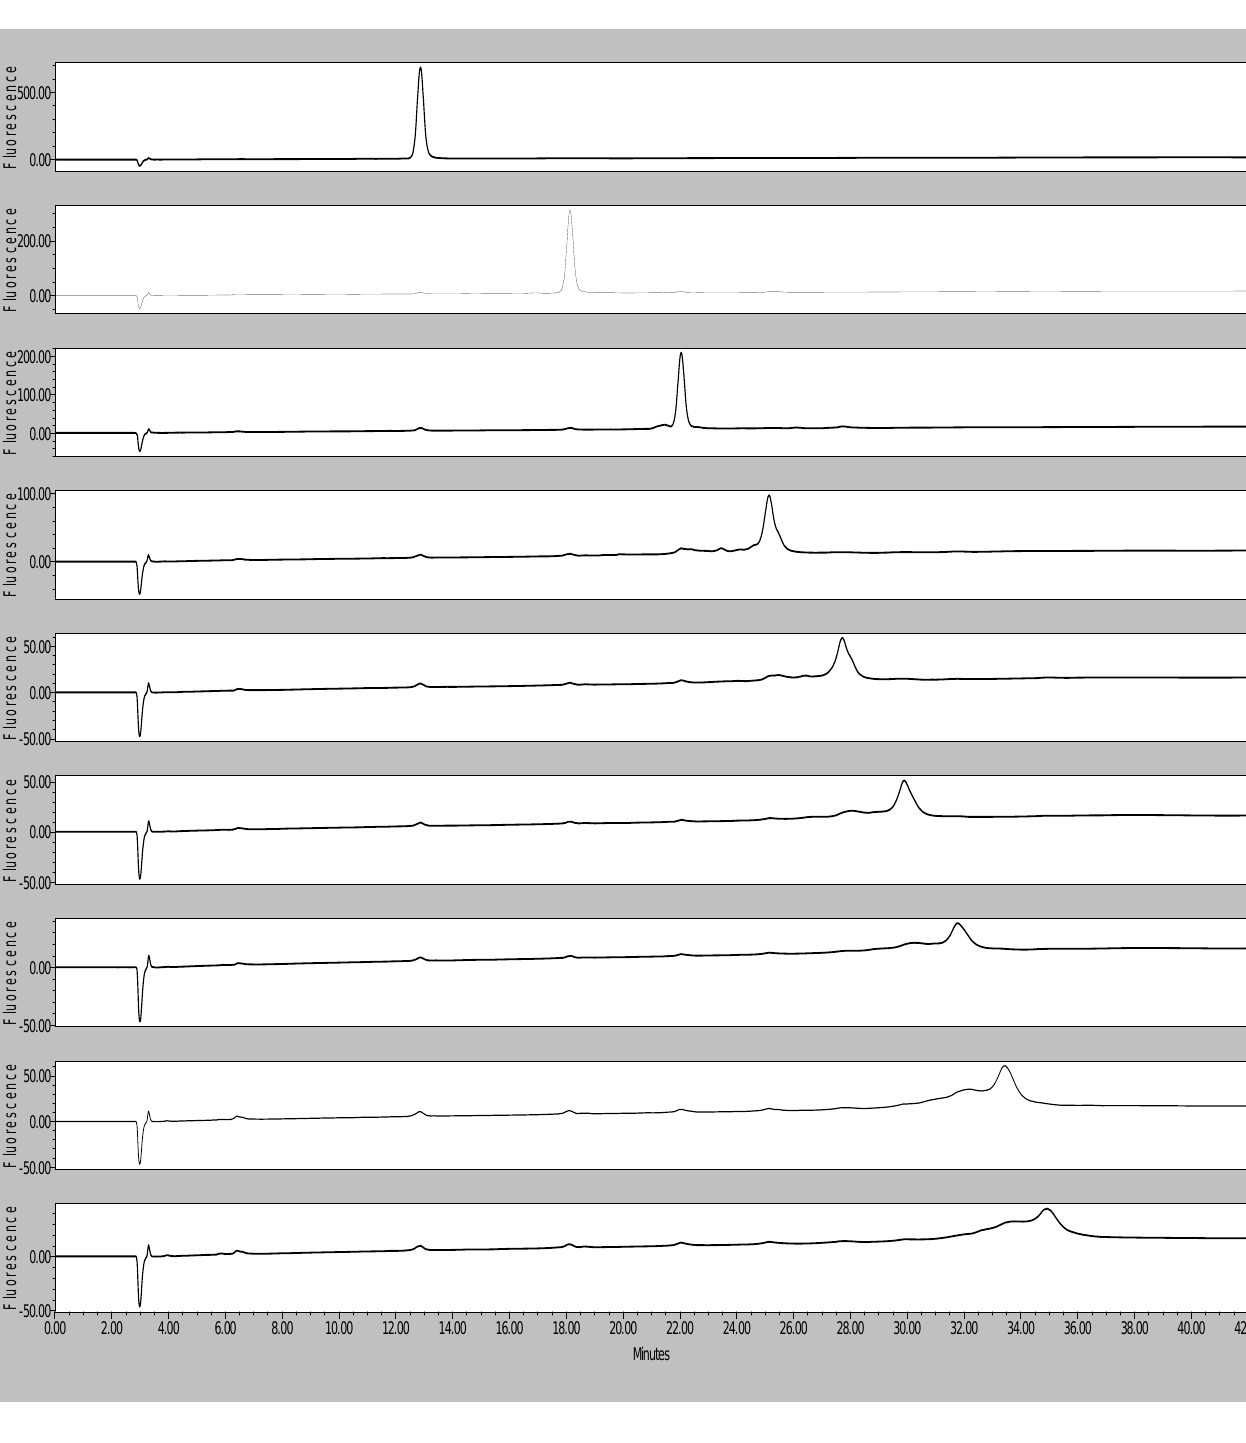
Figure 2. Top to bottom: HPLC-FL separation of DP2 through DP10 procyanidin